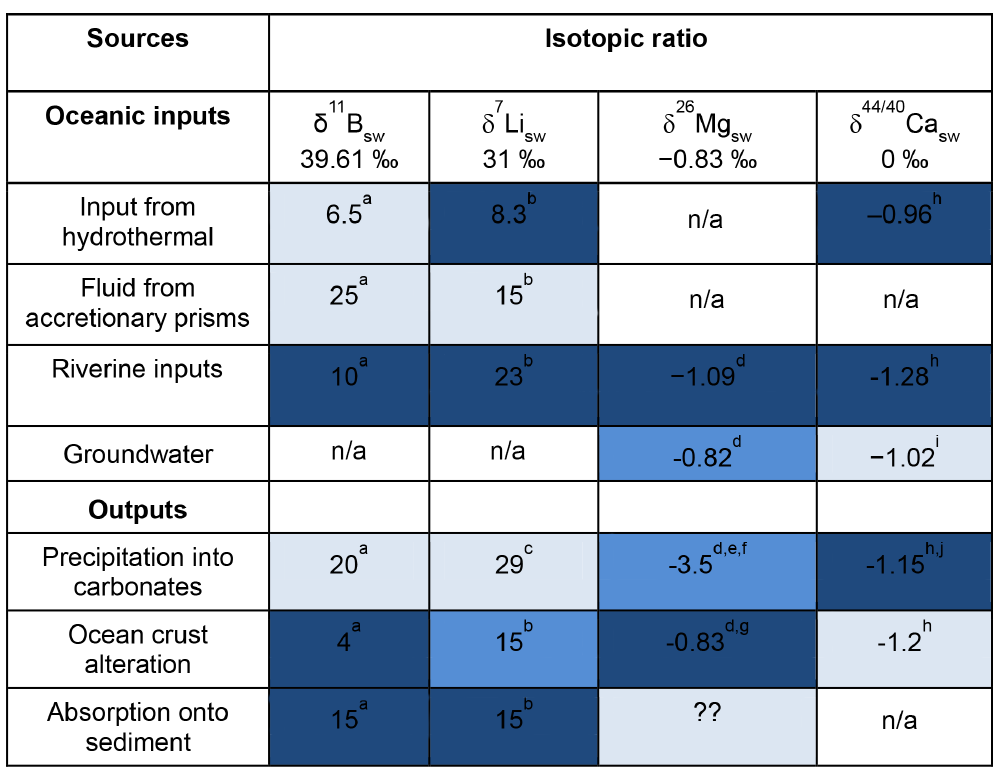
Table 3. The average δ 11 B, δ 26 Mg, δ 44 / 40 Ca and δ 7 Li composition of major fluxes into and out of the ocean. Colour coding reflects the relative importance of each of the processes (darker shading reflects greater importance). The colour coding for boron is based on Lemarchand et al. (2000) and references therein, lithium on Misra and Froelich (2012) and references therein, magnesium on Tipper et al. (2006b) and calcium on Fantle and Tipper (2014) and Griffin et al. (2008) and references therein. Modern δ 26 Mg sw and δ 11 B sw are from Foster et al. (2010) and δ 7 Li sw is from Tomascak (2004). The δ 44 / 40 Ca presented here was measured relative to seawater and hence seawater has a δ 44 / 40 Ca sw of zero per mill by